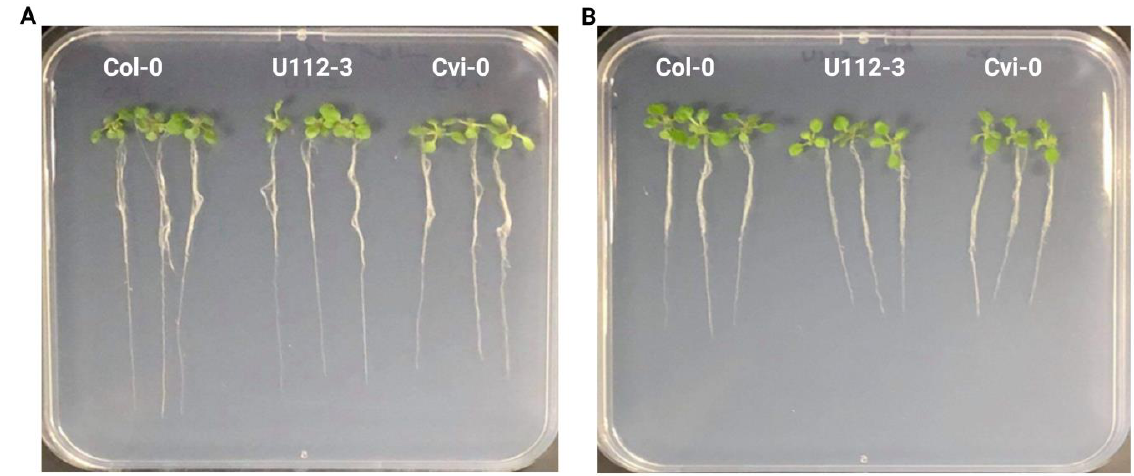
Figure 2. Effect of ailanthone on the Arabidopsis root growth in control ( A ) and treatment ( B ) conditions across three ecotypes, Col-0, U112-3, and Cvi-0.